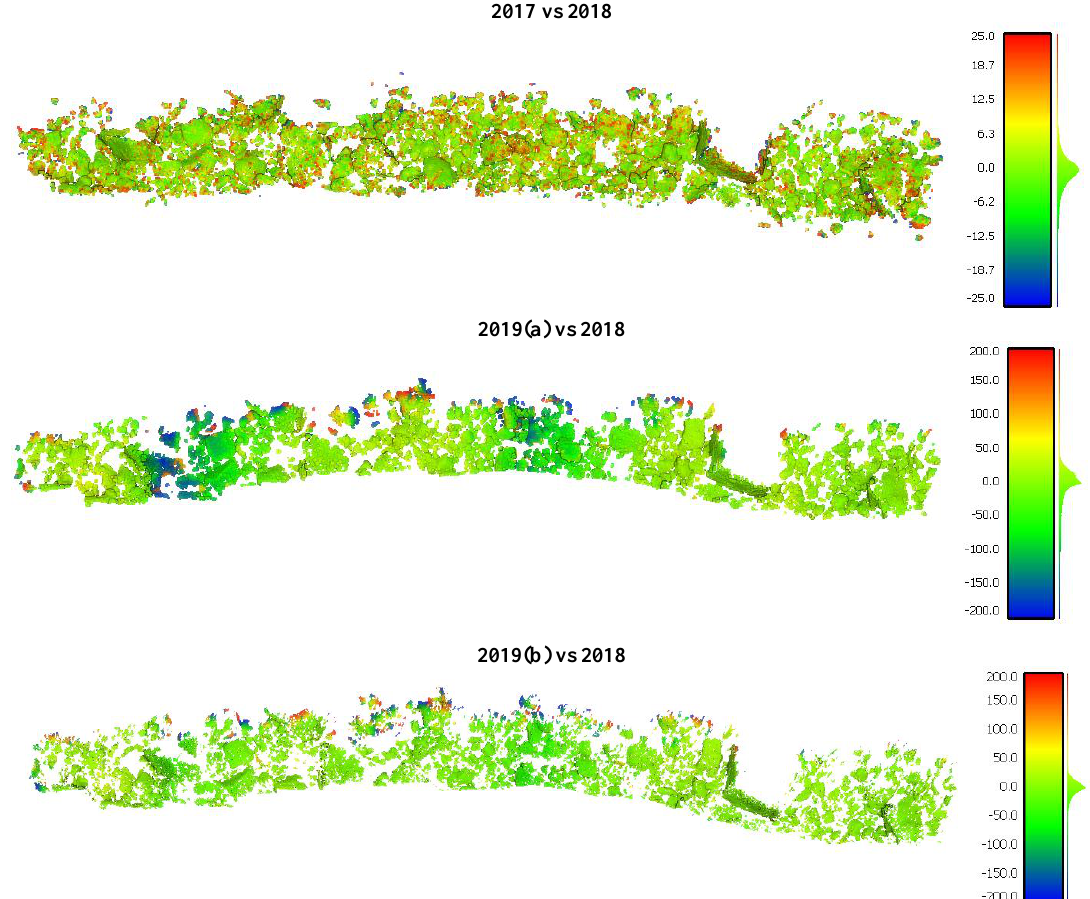
Figure 5 . Point-to-point comparison [mm] on the semantically segmented classes labelled as “stable” used as quality control across the different